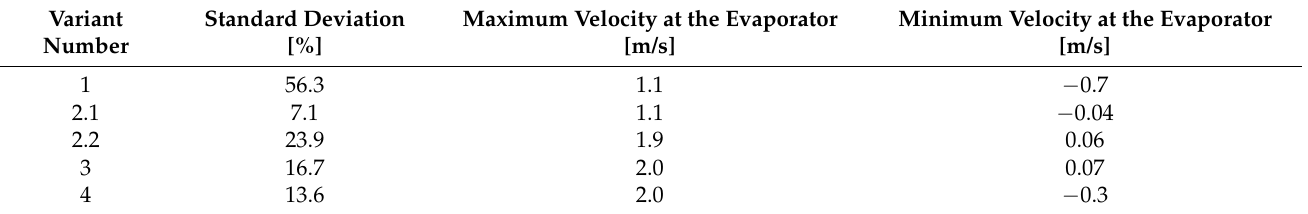
Table 3. Summary of the fan configurations and resulting standard deviations, and minimum and maximum velocities.